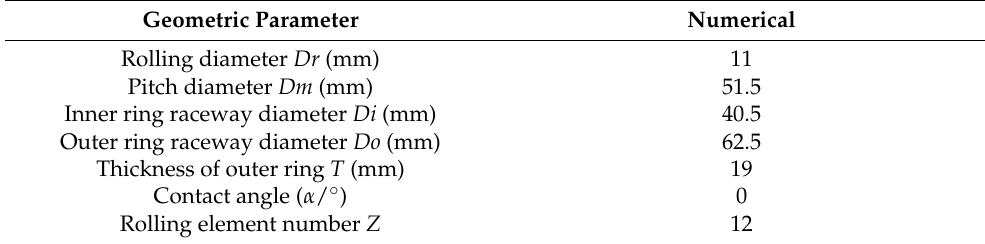
Table 2. The geometric parameters of NU306 bearing.